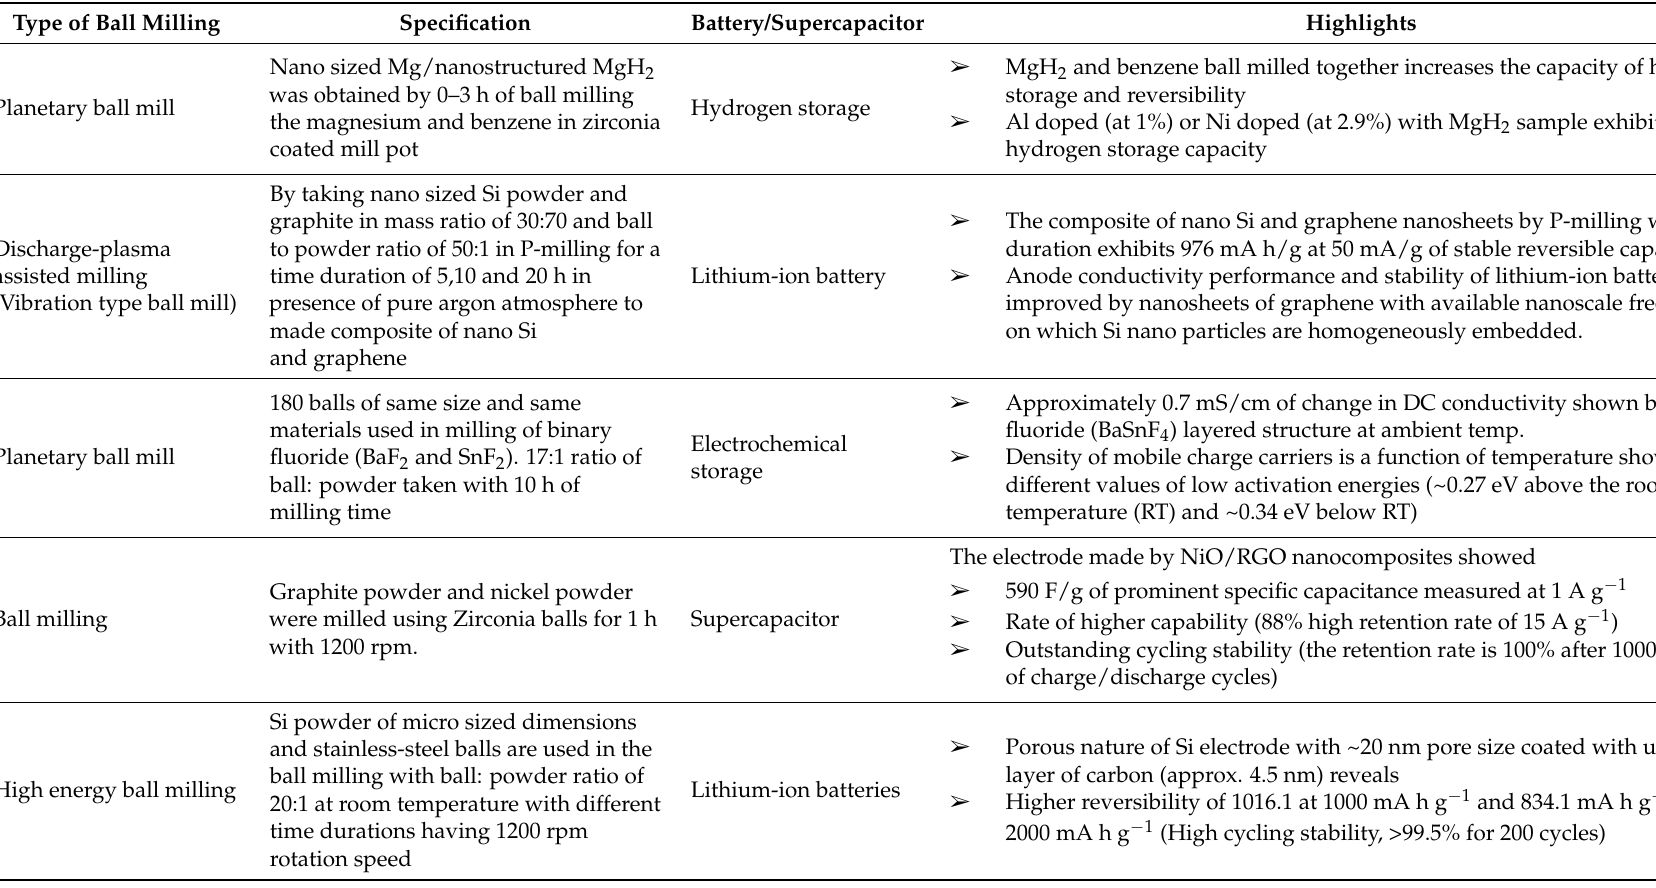
Table 2. Materials that were processed via ball milling demonstrated better performance as energy storage